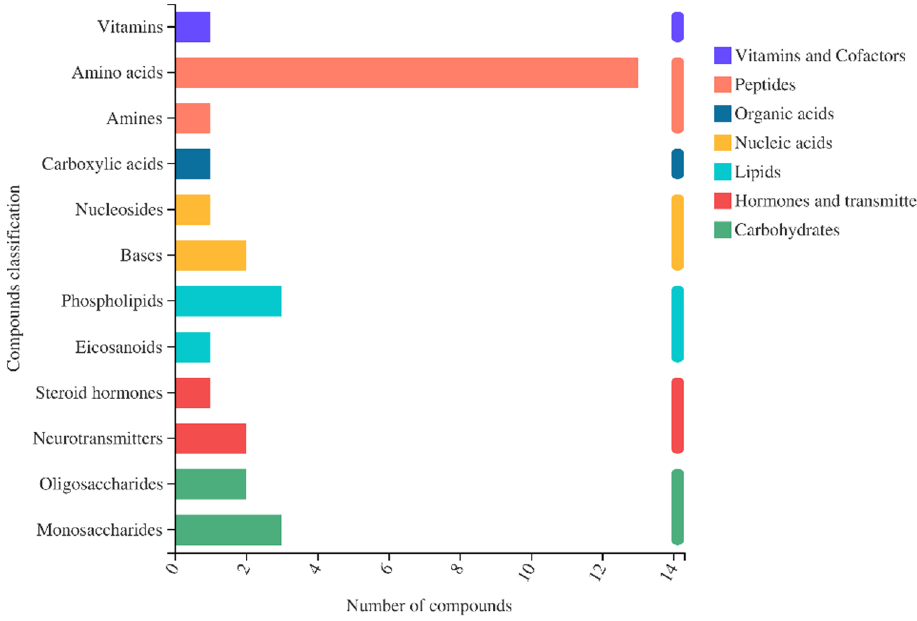
Figure 7. Classification of differential metabolites annotated in KEGG database.